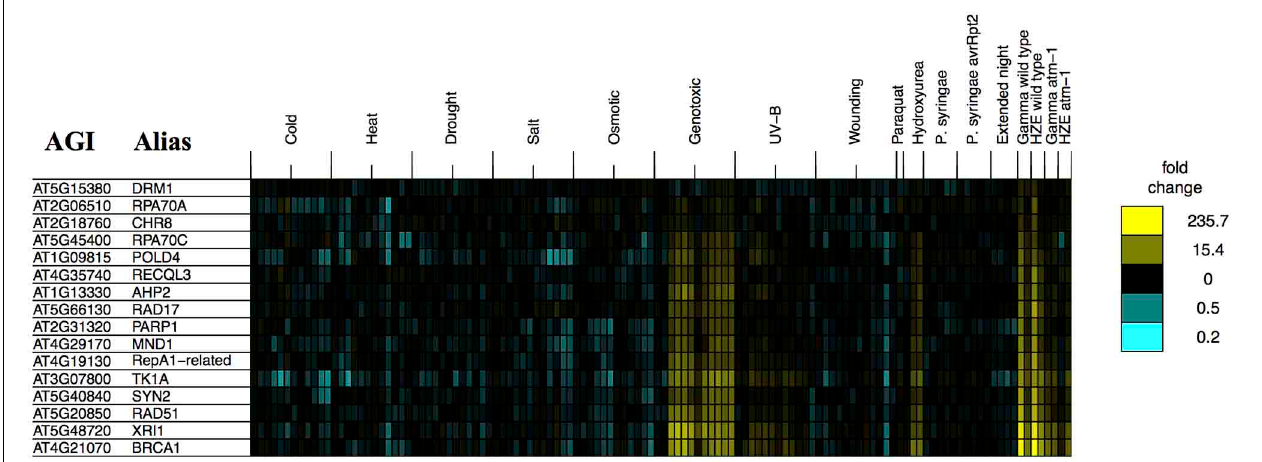
FIGURE 2 | Stress profiles of IR-induced DNA metabolism transcripts. For all transcripts in GO: “DNA metabolic process” that are significantly induced (adjusted p -value < 0.05, fold change > 2) 1.5h after both HZE and Gamma radiation, in WT plants, we display expression profiles across all